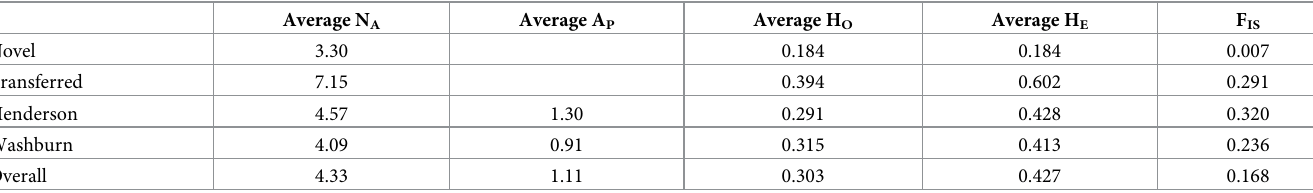
Table 4. Genetic variability at microsatellite loci in two Pinus albicaulis